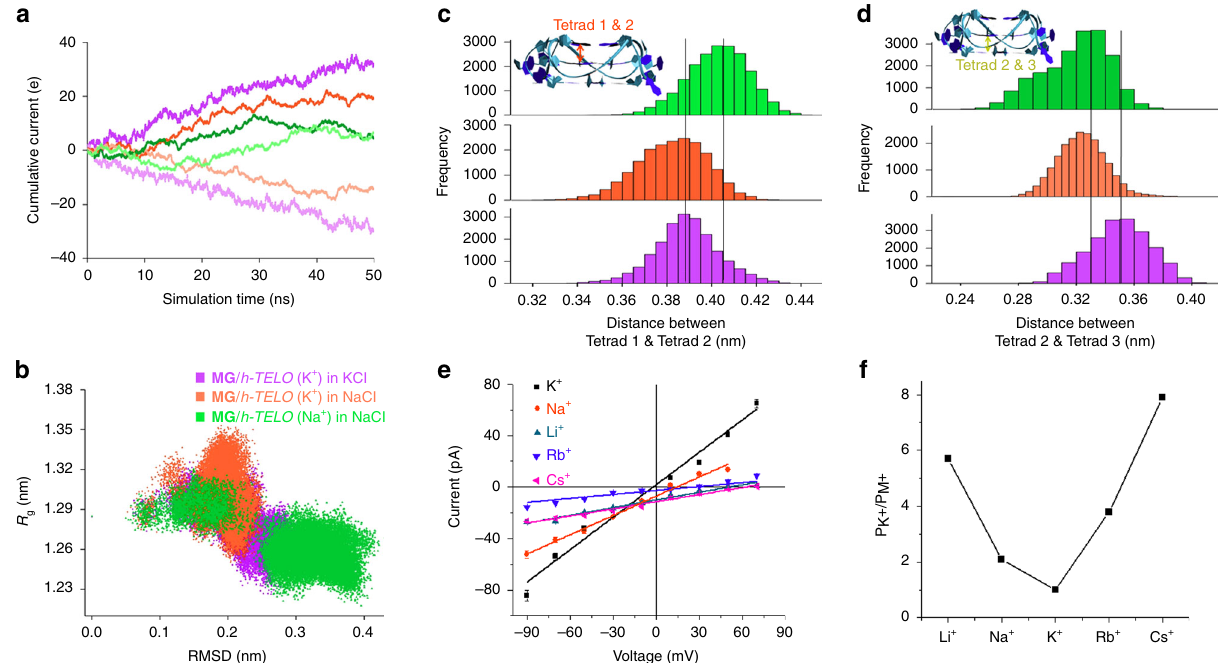
Fig. 6 MG/ h-TELO as K + ionophore. Molecular dynamics simulations of MG / h-TELO in KCl and NaCl electrolyte solutions, represented by purple and orange color, respectively. The Na + -stabilized MG / h-TELO in NaCl electrolyte solution is represented by green color. a Cumulative current fl ow computed for the three systems under the applied voltage biases of + 75 mV, rendered in the dark color and − 75 mV, represented in light color. b 2-D scatter plot of root-mean-square deviation (RMSD) and radius of gyration (R g ) obtained from the equilibrium simulations. Variations of the distance vector along the Z - axis between tetrads 1 & 2 c and tetrads 2 & 3 d are shown for MG / h-TELO ionophore embedded in the lipid bilayer in three different conditions obtained from the simulations. e I – V curves generated from the tail currents of the traces in different buffer conditions. Bi-ionic conditions were used: 10 mM HEPES buffer containing 0.150 M KCl in the cis side and 0.150 M different metal chlorides (LiCl, NaCl, KCl, RbCl, and CsCl) in the trans side. f Permeability ratios of MG / h-TELO obtained for different monovalent cations with respect to K + ion. Source data are provided as a Source Data fi le. Data represented as mean ± SD ( n = 4).